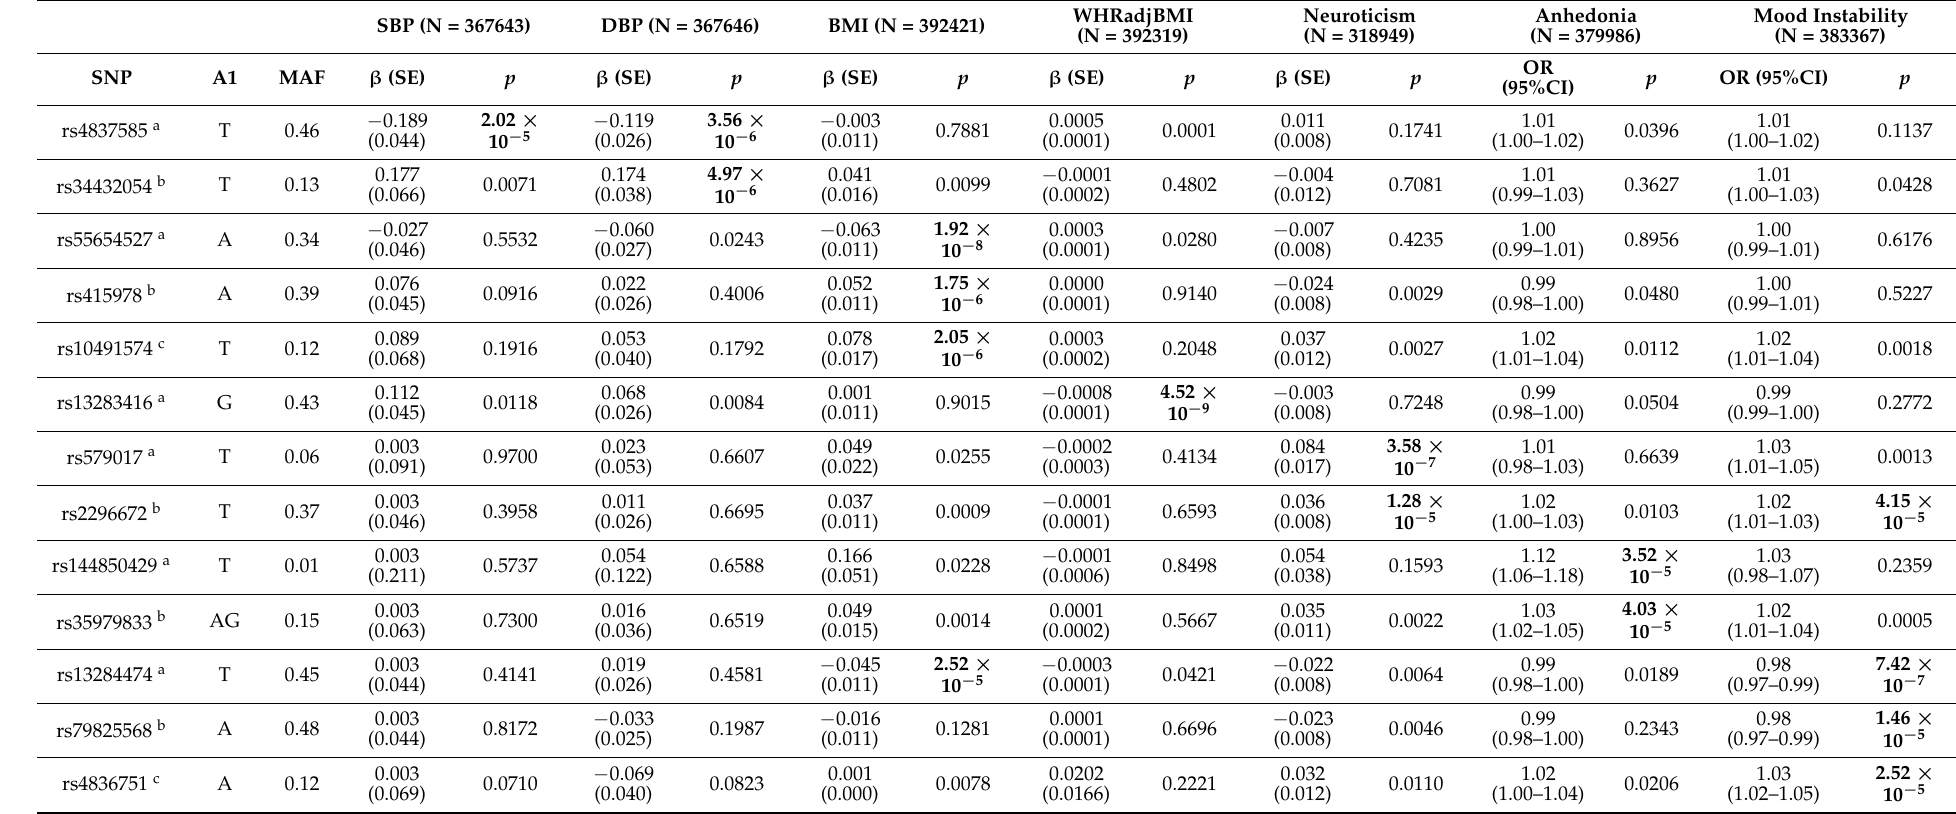
Table 2. Results of main